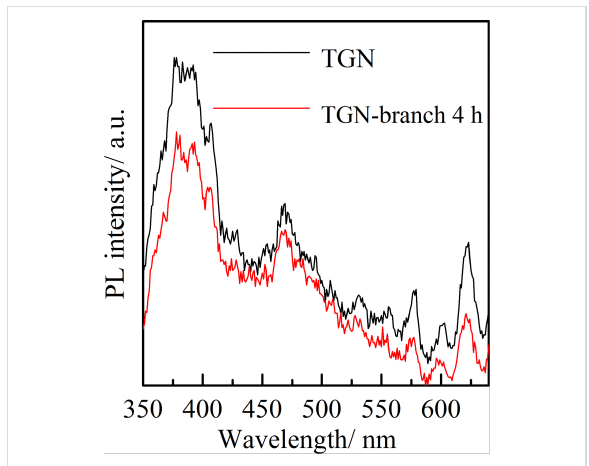
Figure 8: Photoluminescence spectra of TGN and TGN-branch 4